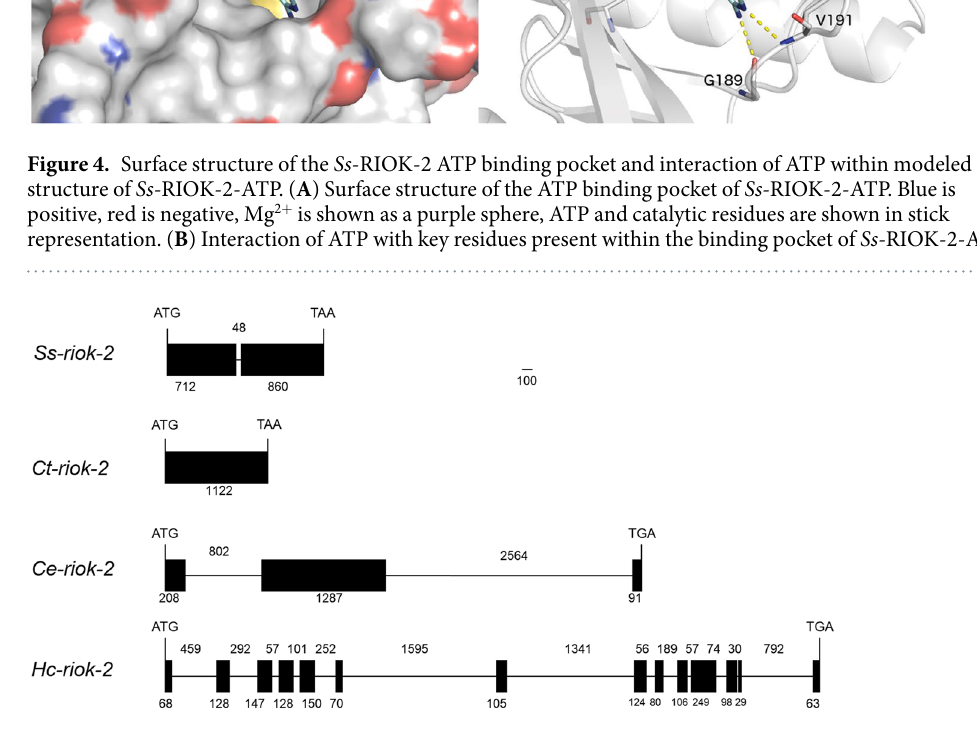
Figure 5. Diagrammatic representation of the genomic organizations of the riok-2 from Strongyloides stercoralis ( Ss-riok-2 ) and orthologues from Chaetomium thermophilum ( Ct-riok-2 ), Caenorhabditis elegans ( Ce- riok-2 ) and Haemonchus contortus ( Hc-riok-2 ). The organization of each gene was determined by aligning the cDNA and genomic DNA sequences, with intron-exon boundaries being defined using the GT-AG rule. Black boxes represent exons, whilst horizontal lines represent introns. Numbers below the boxes indicate the sizes of exons (in nucleotides), whereas numbers above the lines indicate the intron